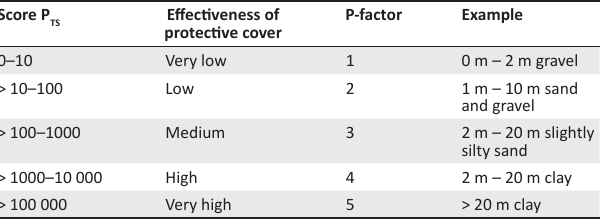
P-factor Example